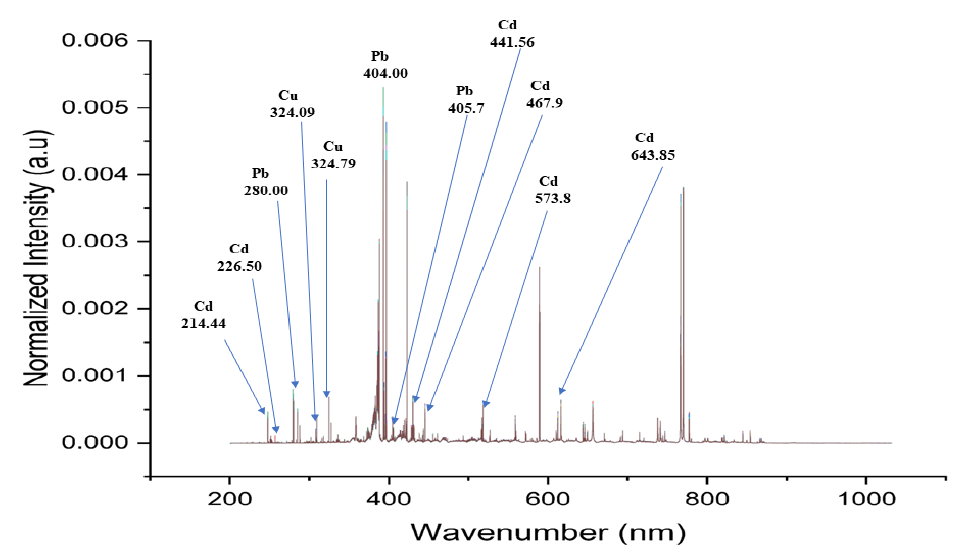
Figure 3. Normalized spectra of 12 Fritillaria varieties.